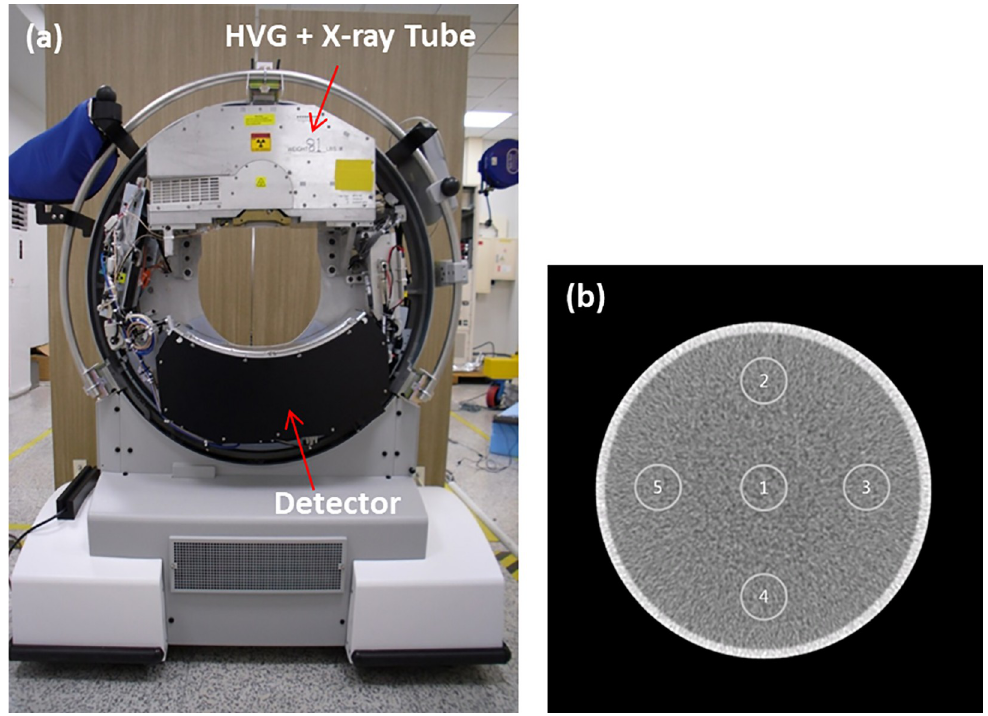
Fig 1. (a) Image of the prototype photon-counting CT system. (b) Illustration of ROIs used for uniformity measurement using the cylindrical water phantom with 150 mm diameter; uniformity value (the absolute value of [center (1) mean CT#- periphery (2–5) mean CT#]). 140 kVp, 1 mA, slice thickness: 0.625 mm, display window: W/L = 400/0